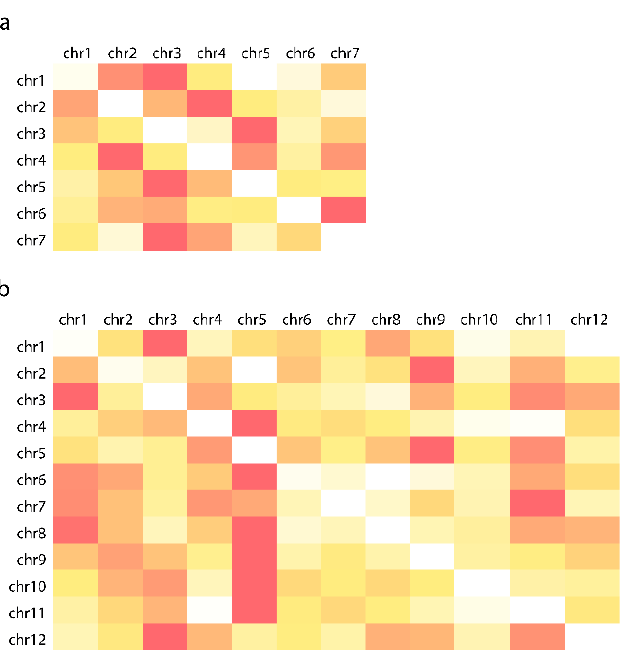
Figure 5. Mean distances of bins grouped by chromosomes. The diagonal white rectangles indicate that in the pseudo-structure of barley ( a ) and rice ( b ), bins of the same chromosomes are closer to each other compared to bins located on other chromosomes. The darker the shade the larger is the value, white is the minimum of the row.